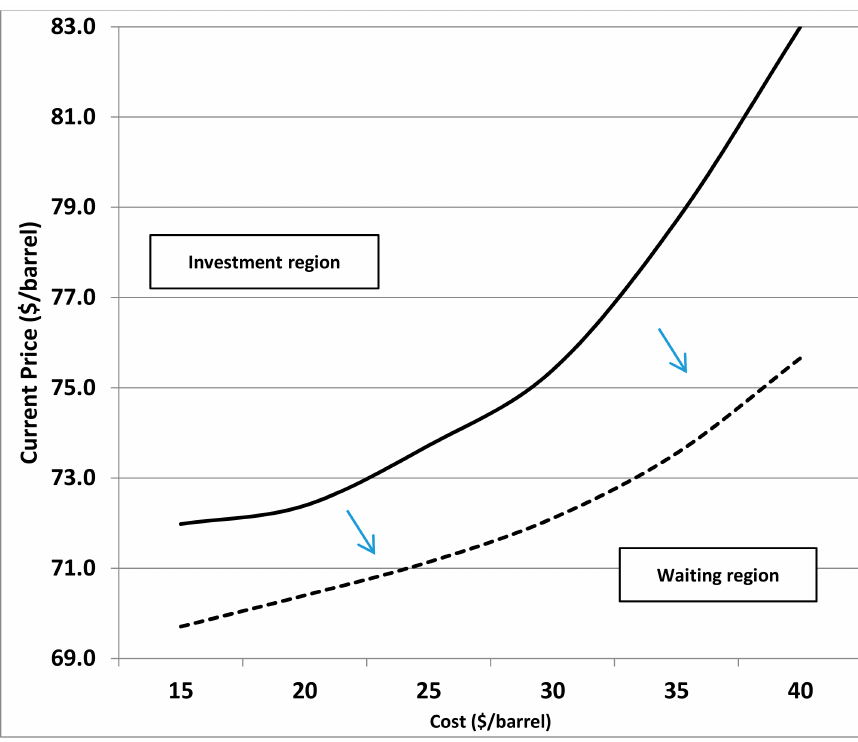
Figure 4. Opportunity to delay investment: Trigger price as function of cost c